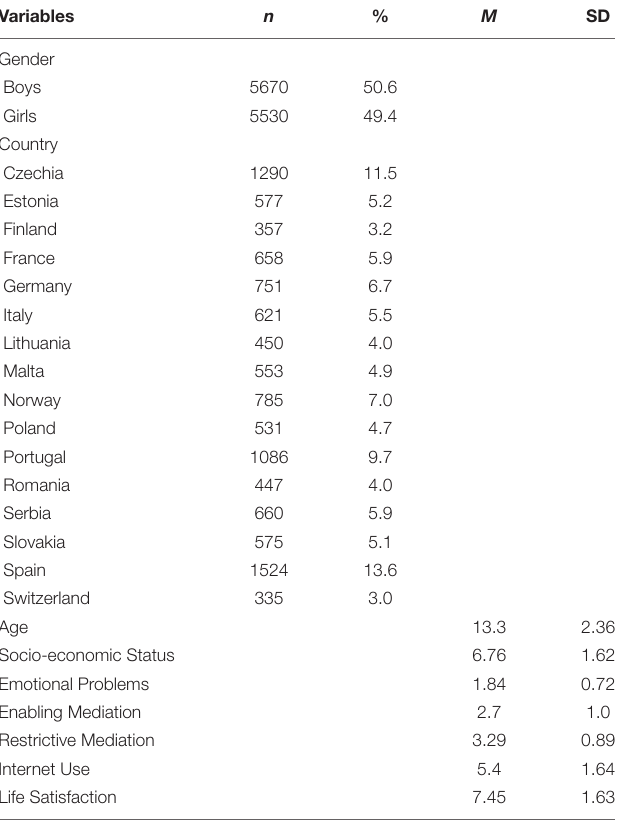
TABLE 1 | Descriptive statistics of demographic, independent, and dependent